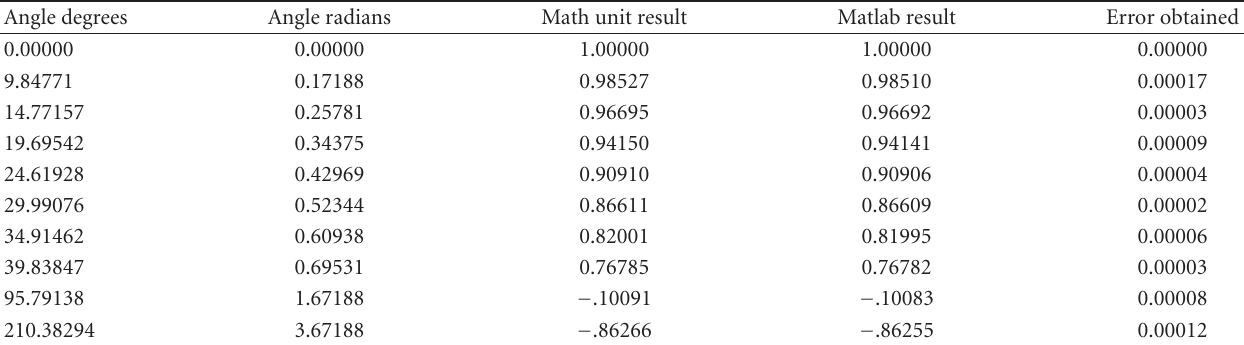
Table 2: Results obtained from the mathematical unit.